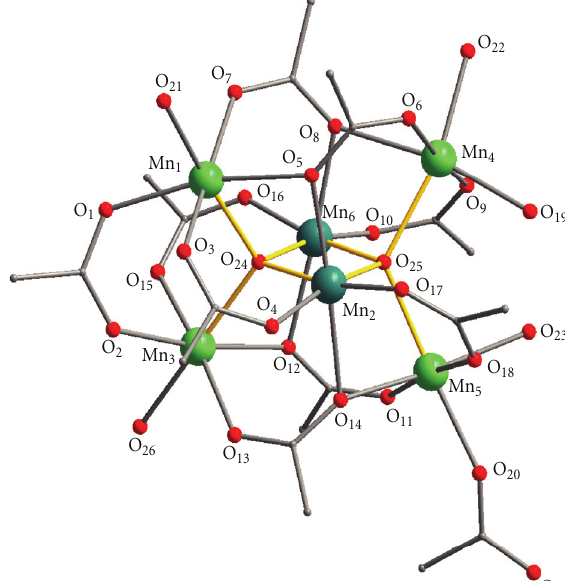
Figure 1: A partially labeled plot of the repeating unit of ( 1 ) ∞ . The yellow lines emphasize the [Mn 4II Mn 2III ( μ 4 -O) 2 ] 10+ core. Color code: Mn II , green; Mn III , dark green; O, red; C, grey. H atoms are omitted for clarity.